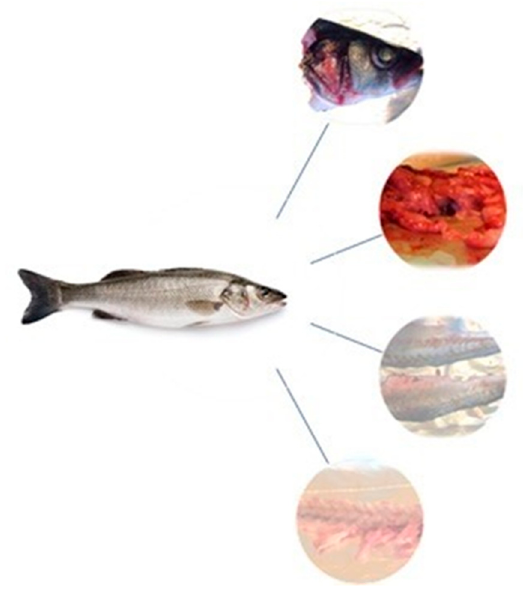
Figure 1 . Sea bass side streams (head, viscera, skin, and bones). Figure 1. Sea bass side streams (head, viscera, skin, and